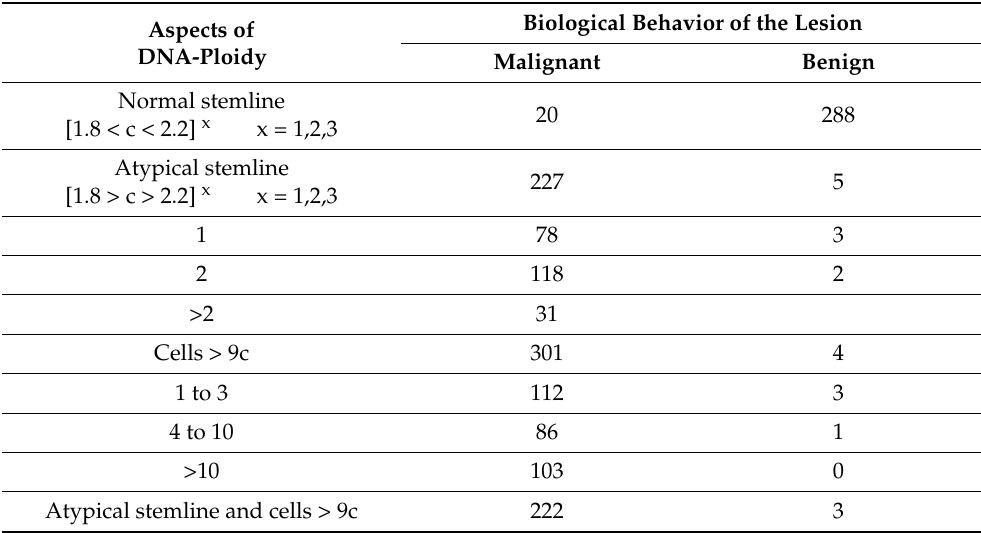
Table 5. Frequency of met criteria for DNA ploidy in relation to the biological behavior of